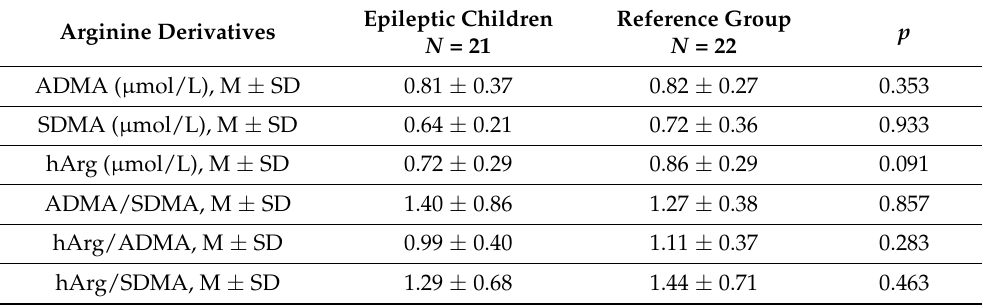
Table 3. Levels of arginine derivatives in all the analyzed groups.